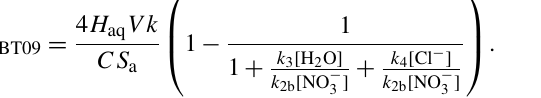
b The ϕ ClNO 2 and the correlation coefficient